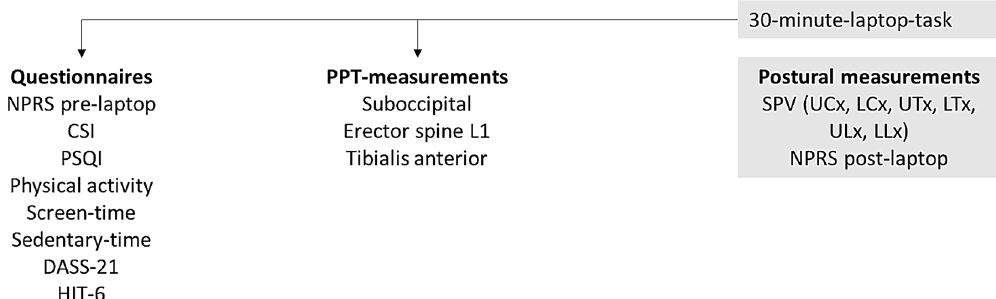
Figure 1. Chronology of the test procedure for both groups. We refer to our previous work and Appendix C concerning the SPV-measurements (grey box) 11 (NPRS = Numeric Pain Rating Scale, CSI = Central Sensitization Inventory; PSQI = Pittsburgh Sleep Quality Index; DASS = Depression, Anxiety, Stress Scale; HIT = Headache Impact Test; PPT = Pressure Pain Threshold; SPV = Spinal Postural Variability) (Microsoft PowerPoint 2016, version 1, Microsoft